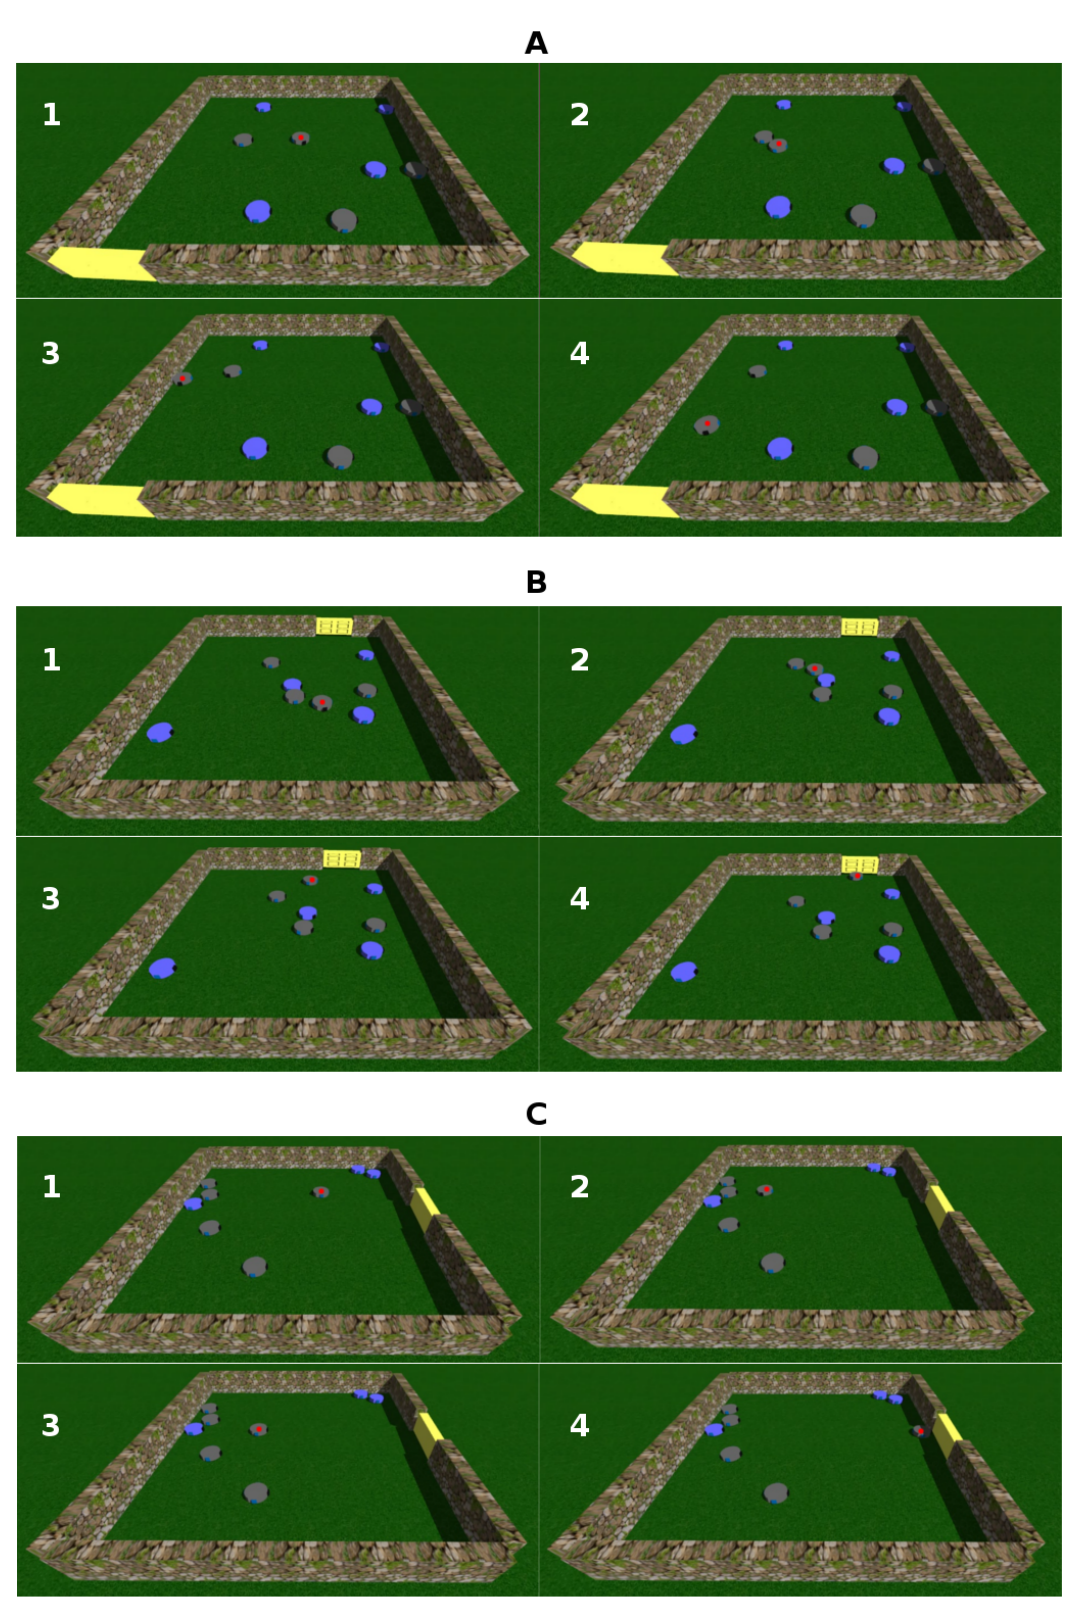
Fig. 4. Navigation Behavior. The cases A, B and C consist of four pictures showing the trajectory of the agent endowed with the evolving brain (highlighted with red dot). In Case C, we note that the agent moves away from the door since it is looking in the opposite direction to it. As the agent turned, it sees the door and moves toward